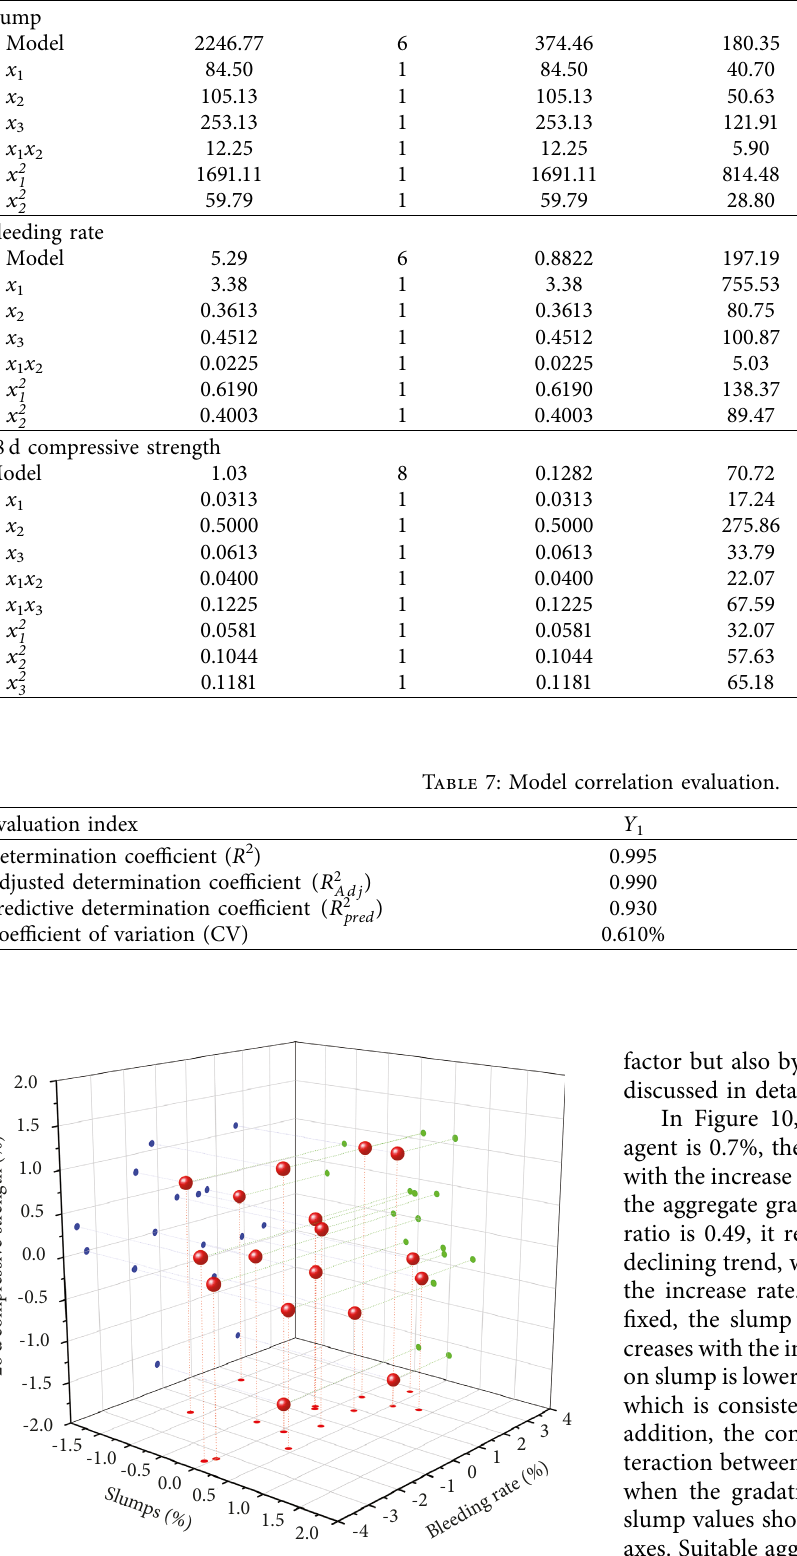
Figure 8: Three-dimensional error coordinate system of the re- gression